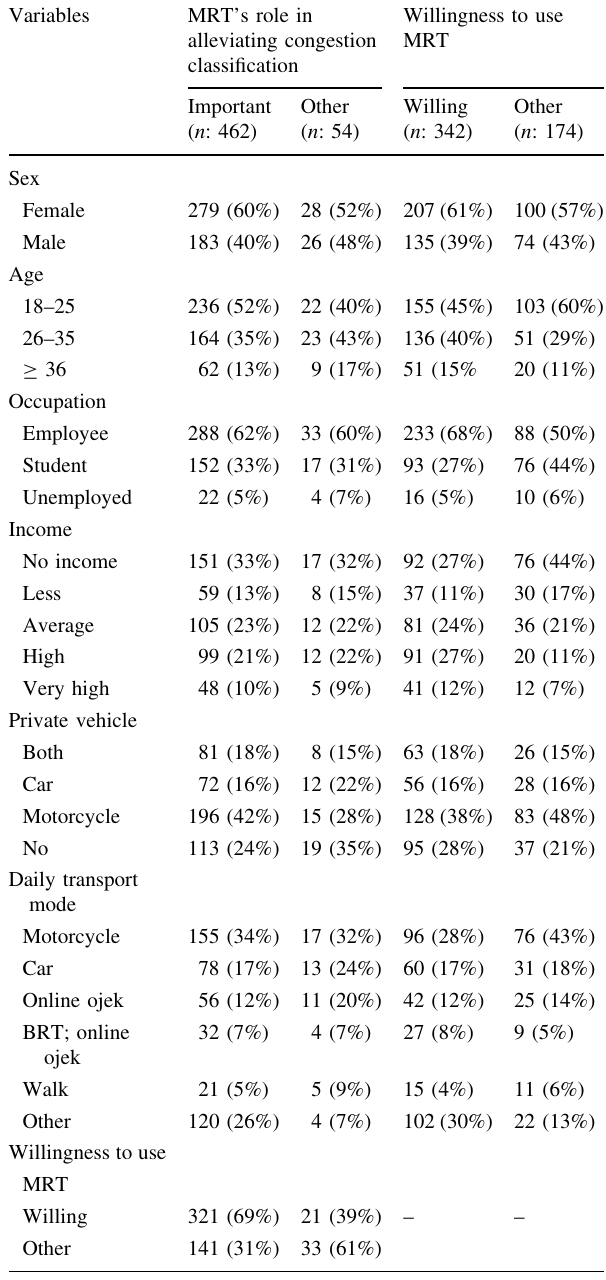
Table 5 Description analysis of variables by MRT’s role in allevi- ating congestion and willingness to use MRT Variables MRT’s role in alleviating congestion